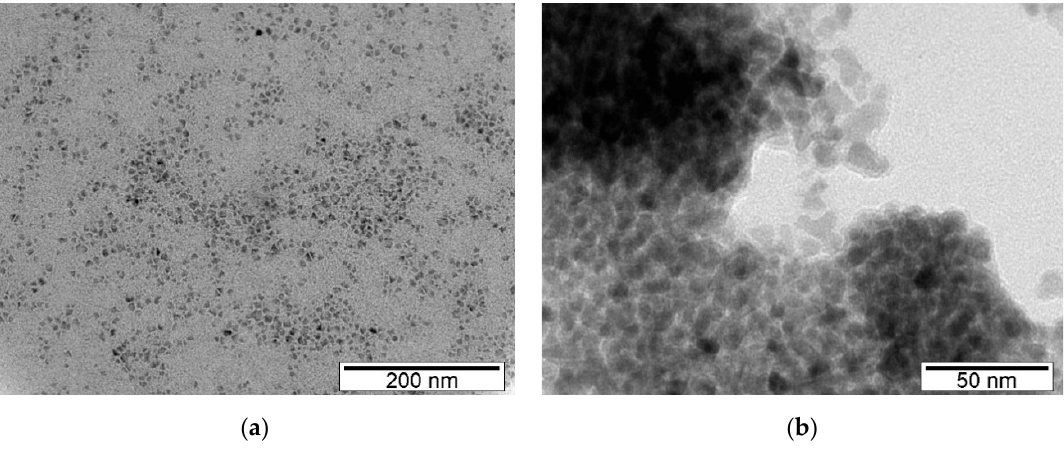
Figure 1. representative TEM images of QDs: (a) ZnS and (b) CdS. Figure 1. Representative TEM images of QDs: ( a ) ZnS and ( b ) CdS. Table 1. Results from DLS analysis (mean ± sd), potential zeta and electrophoretic mobility in water